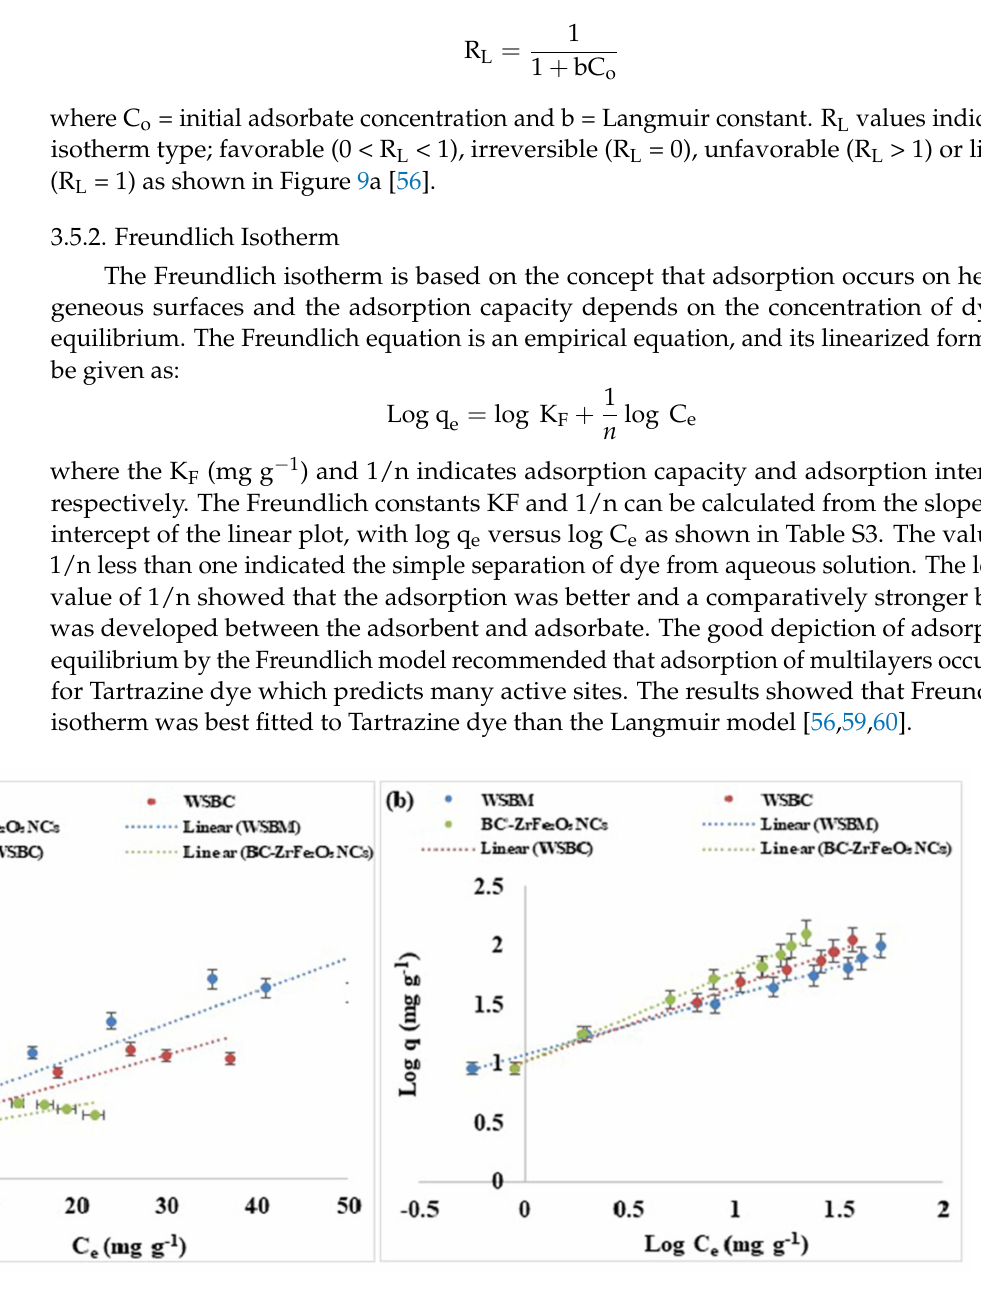
Figure 9. Adsorption equilibrium models: ( a ) Langmuir, ( b ) linearized Freundlich of adsorption of Tartrazine dye by WSBM, WSBC, and BC-ZrFe 2 O 5